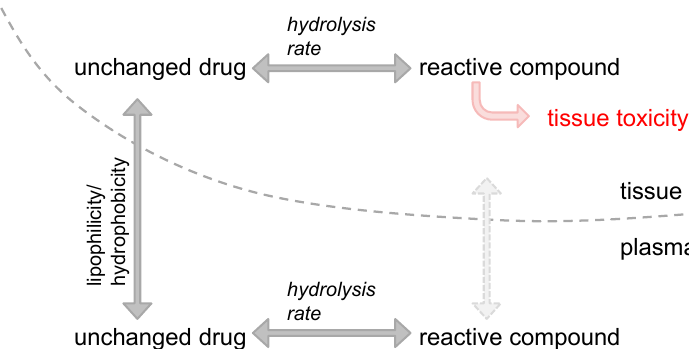
Figure 1. Impact of hydrolysis rate (aquation reaction kinetics) on tissue distribution and toxicity. Tissue distribution of unchanged platinum drug is mainly determined by the lipophilicity or hydrophobicity of its carrier and leaving group, respectively. After substitution with water, the positively charged reactive compound present in plasma (and potentially bound to plasma proteins) can hardly penetrate tissue barriers. In contrast, reactive compounds present in the tissue will lead to toxicity.